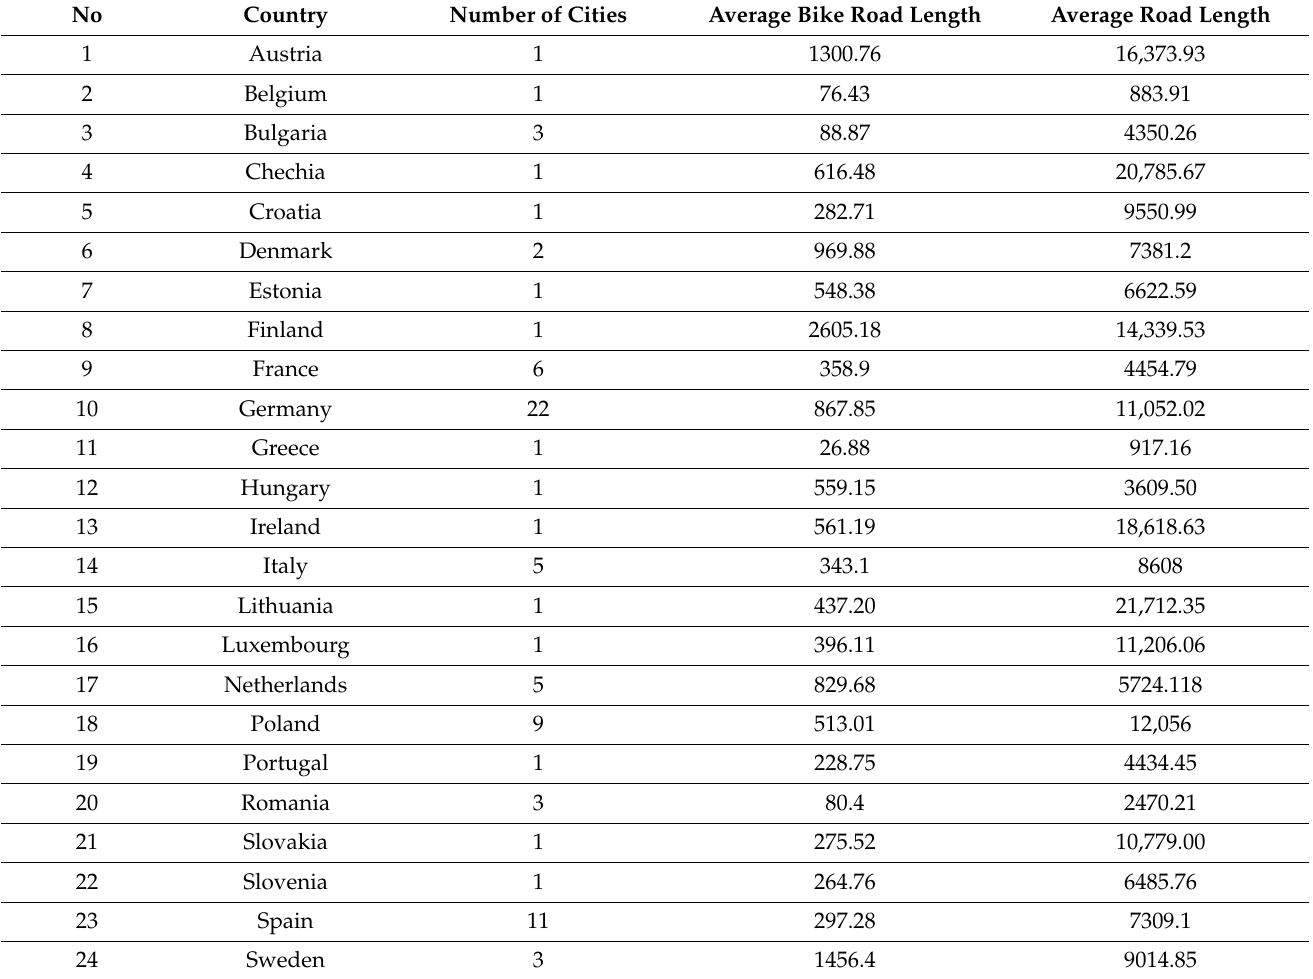
Table 4. European countries—the number of analyzed smart cities and bike road